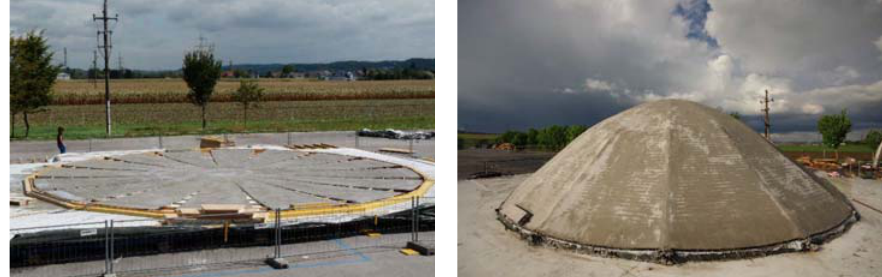
Figure 21: Large-scale experiment in Austria: erection of a spherical shell using PFHC (2012).